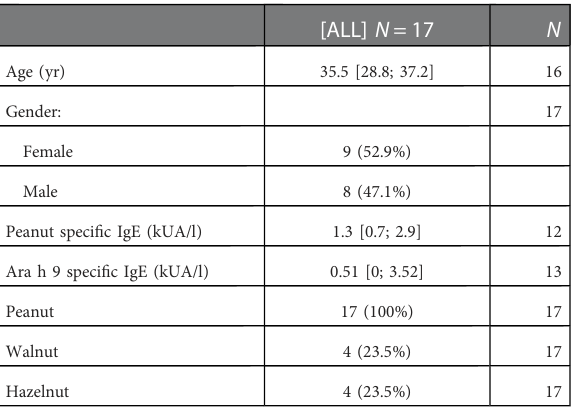
TABLE 2 Patient details for Spain.